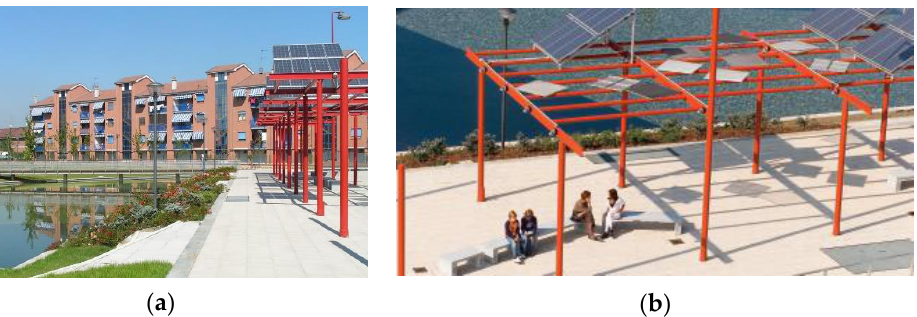
Figure 5. Ground ( a ) and aerial ( b ) view of the pergola equipped with PV panels in the public area (source: © Municipality of Alessandria).